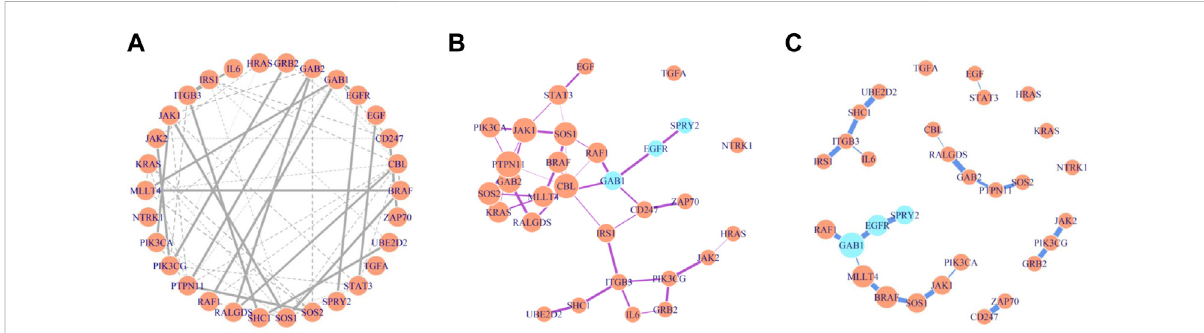
FIGURE 5 Gene regulatory network constructed by BMRF.P based on different thresholds. The width of edges is proportional to the existence probability andnodesizein (B) and (C) isproportionaltonumberofimmediateneighbors. (A) These55edgesareofestimatedexistenceprobabilitygreaterthan 0.5; (B) These 41 edges are of estimated existence probability greater than 0.7; (C) The 20 edges are of estimated existence probability greater than